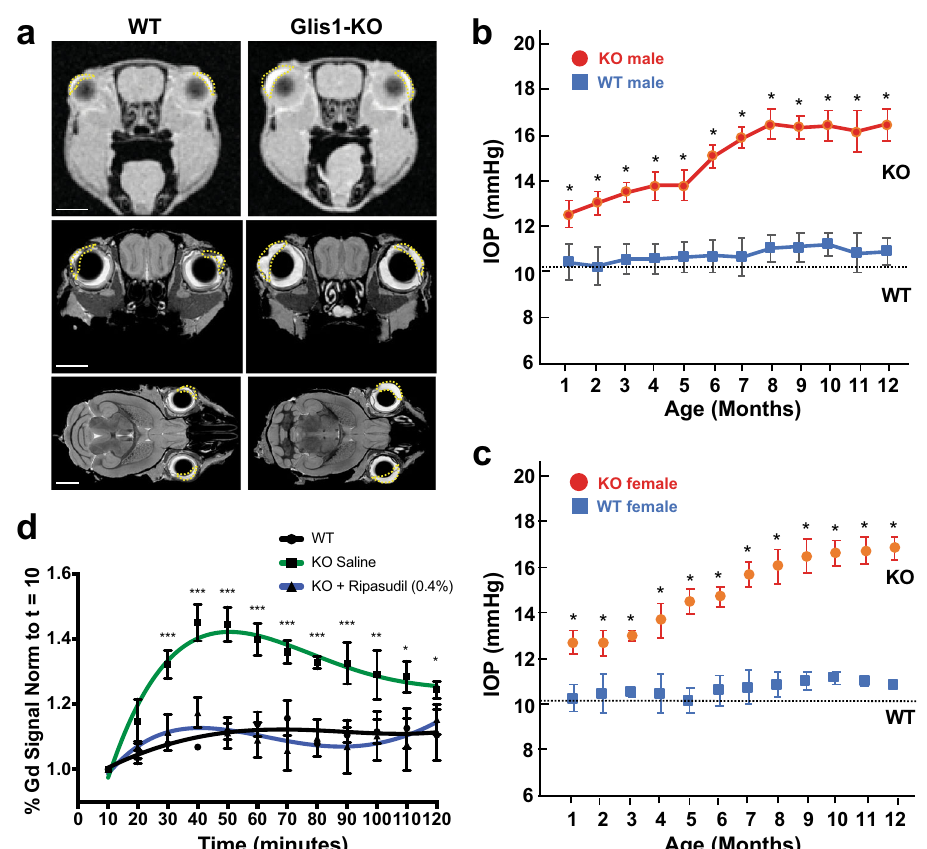
Fig. 1 Anterior chamber is enlarged, IOP elevated, and AqH dynamics altered in Glis1 -KO mice. a Representative MRI images from 2.5-month-old WT and Glis1 -KO mice showing the increased size of the anterior chamber in Glis1 -KO mice compared to WT. The upper two images are in vivo images acquired by dynamic contrast enhancement in the eye. The lower four images are coronal and sagittal sections of eyes from fi xed specimen stained with gadolinium using active staining. The anterior chamber is outlined by the dotted line. Scale bar = 2 mm. b , c Comparison of IOP levels in male ( b ) and female ( c ) WT (squares) and Glis1-KO (circles) mice as a function of age. Male mice examined: at 1 and 2 months ( n = 3); 3 ( n = 5); 4 and 7 ( n = 8); 5 ( n = 6); 6, 11, and 12 months ( n = 7). For female mice: 1 and 2 months ( n = 10); 3 – 7, 9, and 10 months ( n = 4); 8 ( n = 5); 11 and 12 months ( n = 3). IOP data from left and right eyes were combined and 4 IOP measurements/eye/time points were performed; thus, a total of 24 – 80 measurements at each time point. Data are represented as means ± SD. Statistical analyses were performed with a two-tailed Student ’ s t test. * p < 10 − 5 . The dotted line indicates basal IOP level in 1 – 3-month-old mice. d AqH dynamics was examined by Gd-enhanced MRI over a 2 h period. Percent of Gd signal enhancement was determined and plotted. Left eye of 2-month-old WT mice ( n = 3; black line) and Glis1 -KO mice ( n = 4; red line) was treated topically with saline and the right eye of Glis1-KO mice with Ripasudil (0.04%) ( n = 4; blue line). Data are represented as means ± SD). Statistical analyses were performed with a